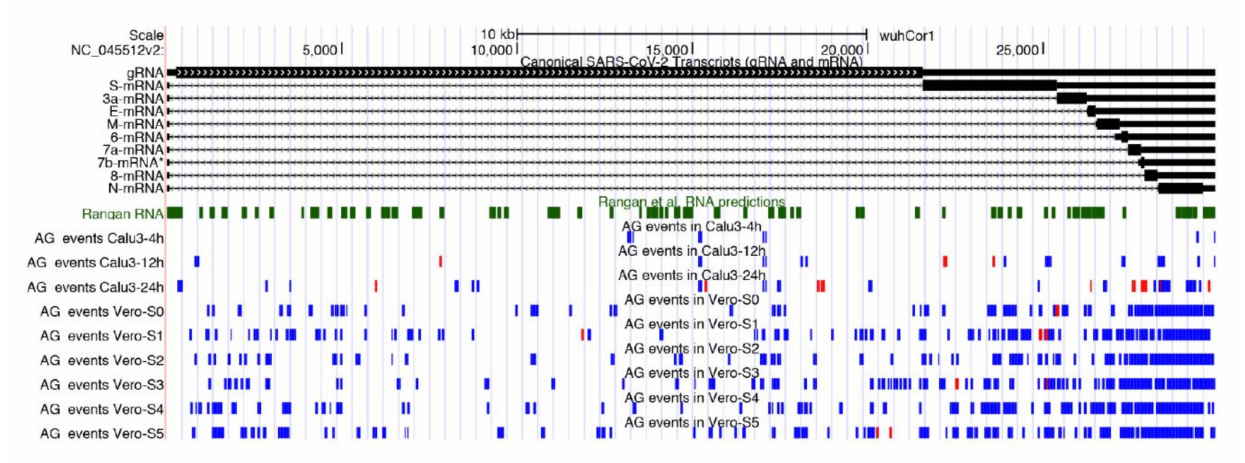
Figure 3. Genomic context of A-to-I RNA editing clusters detected in total RNAseq data from infected Calu-3 cells and Vero cells. We report also known SARS-COV-2 transcripts and putative RNA secondary structures from Rangan et al. [44]. A-to-I clusters in forward orientation are marked in blue, while clusters in reverse orientation are in